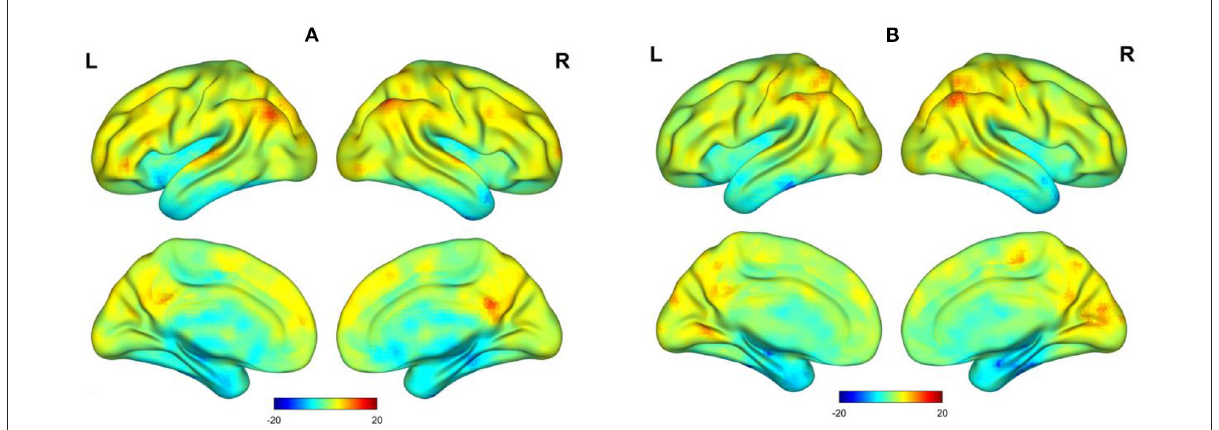
FIGURE1 Surface view of t -value spatial distribution maps of one-sample t -tests on functional stability (z-scores) in an auditory memory task. (A) Awake state. (B) Dexmedetomidine sedation